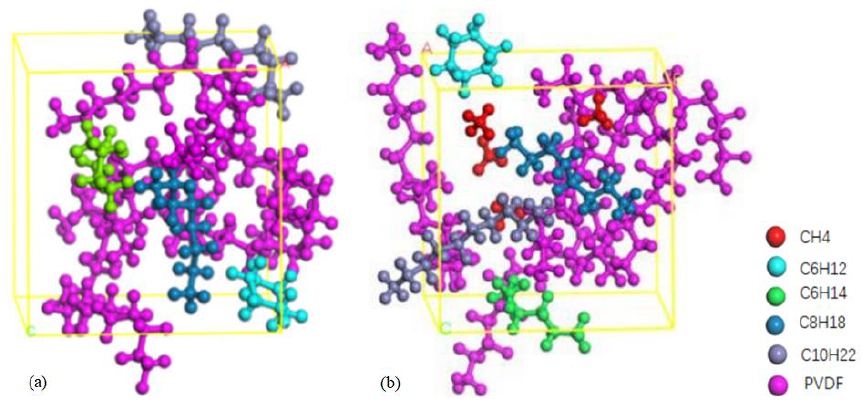
Figure 2. Typical crude oil molecules models: ( a ) C 6 H 12 , ( b ) C 6 H 14 , ( c ) C 8 H 18 , ( d ) C 10 H 22. Colored balls represent C in red, H in yellow.